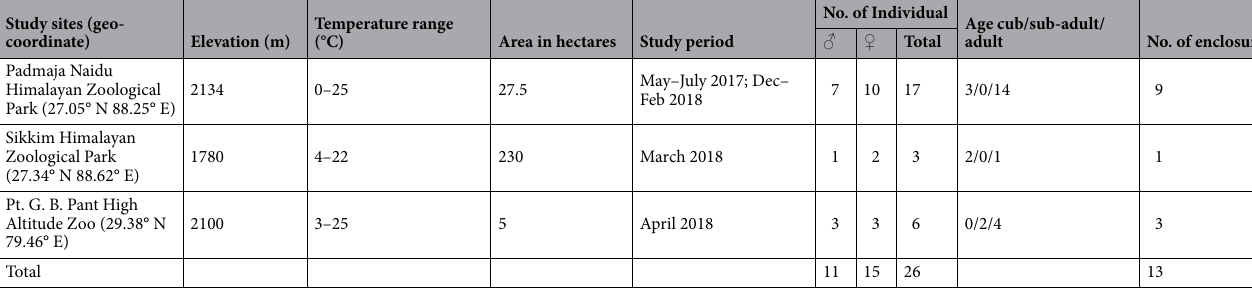
Table 3. Details of various study sites and study individuals observed in the present study.